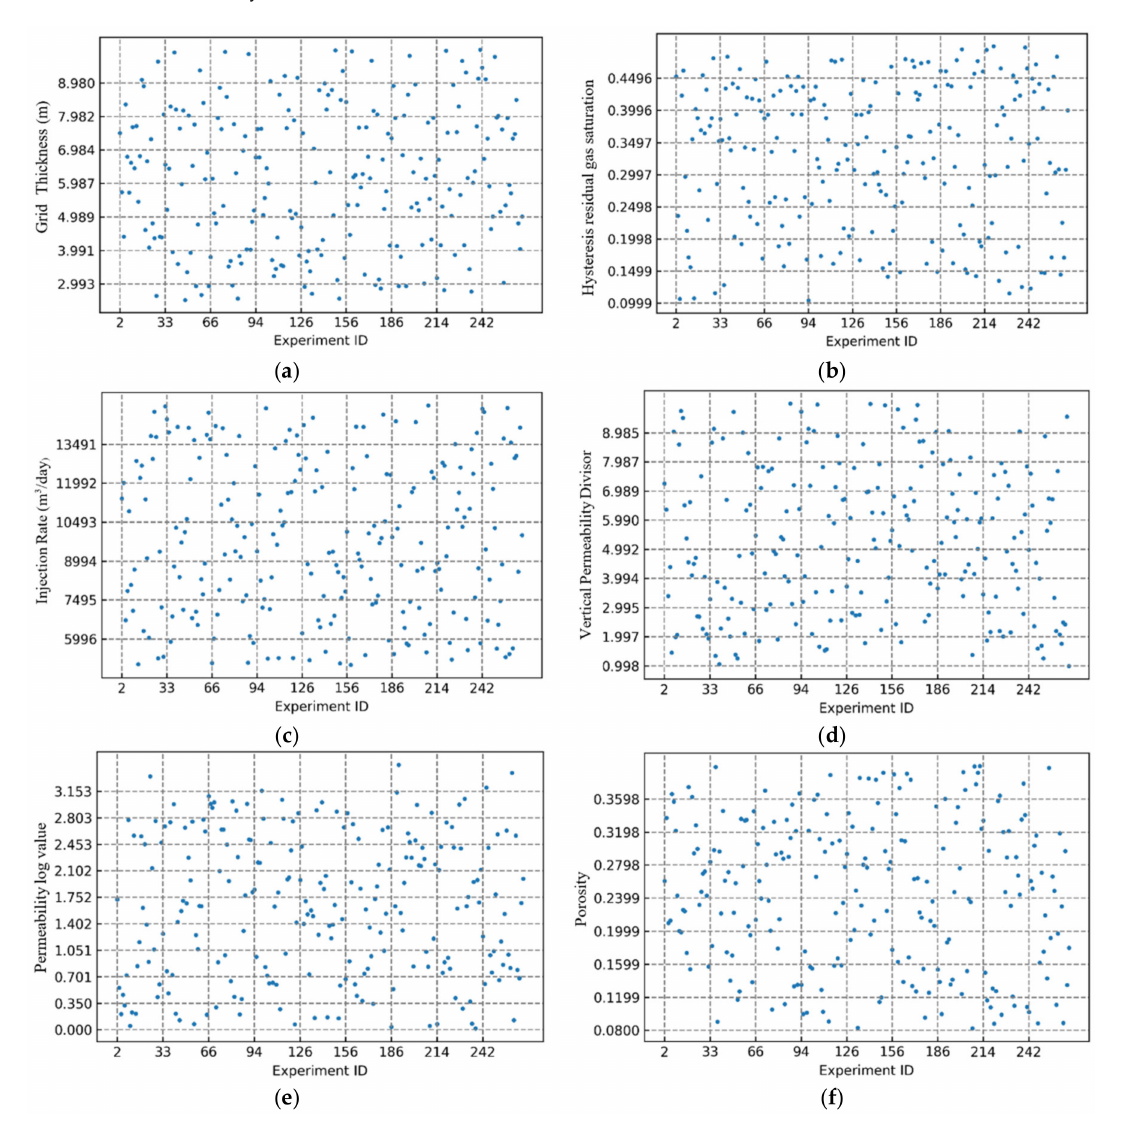
Figure 8. Input parameter distribution generated by the randomized process. ( a ) grid thick- ness; ( b ) hysteresis residual gas saturation; ( c ) gas injection rate; ( d ) vertical permeability divisor; ( e ) permeability log value; ( f )